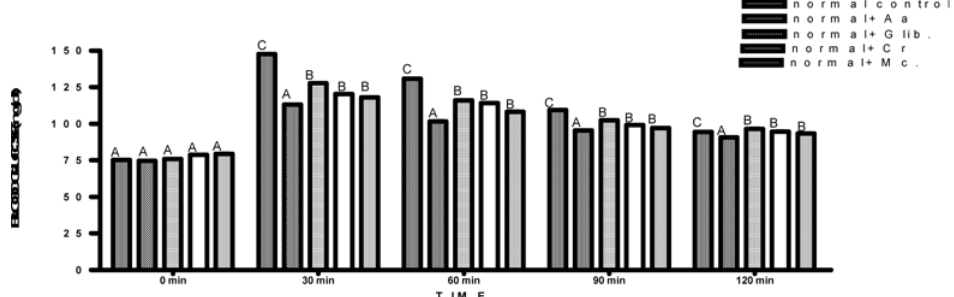
Fig.1 . Histogram showing Glucose levels (mg/dl) in rats at different time intervals in different treatment groups under oral glucose tolerance test (OGTT).